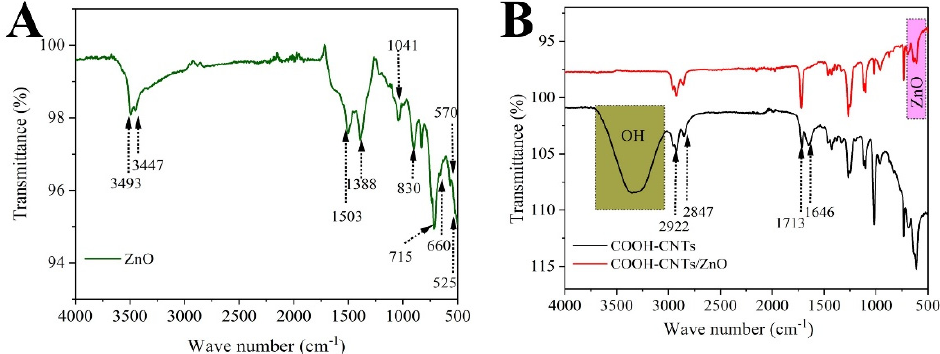
Figure 2. FTIR spectra of ( A ) biogenic ZnO − NPs and ( B ) carboxylated CNTs and CNTs/ZnO com-